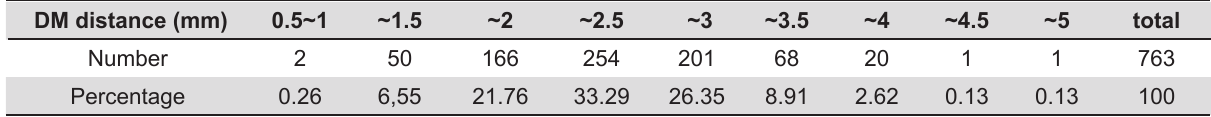
Table 2- The variable distance of the DM (the distance between the mesiobuccal and the distobuccal root canal orifice) DM distance (mm)